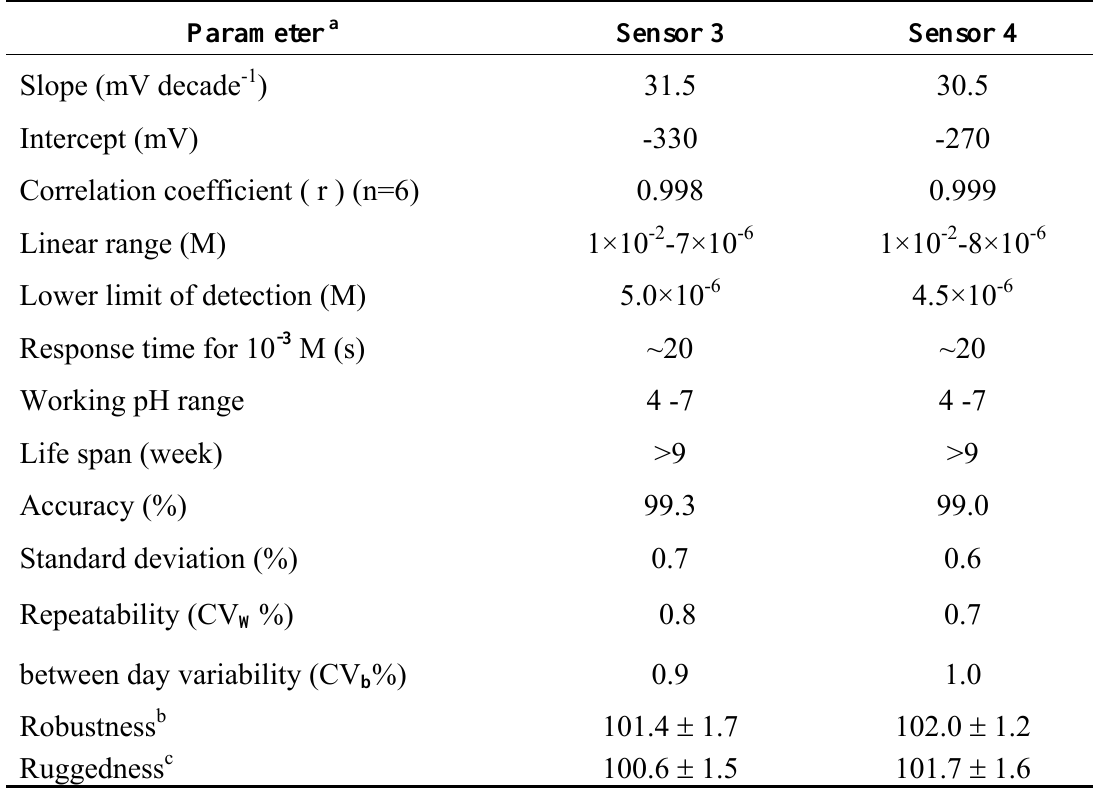
Table 2. Potentiometric response characteristics of o -NPOE plasticized PVC membrane sensors with KT p